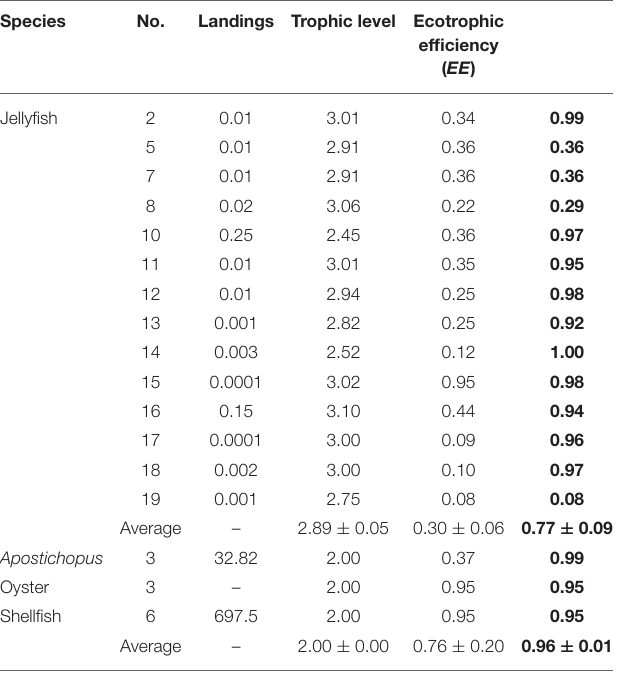
Adjusted EE value are in bold.